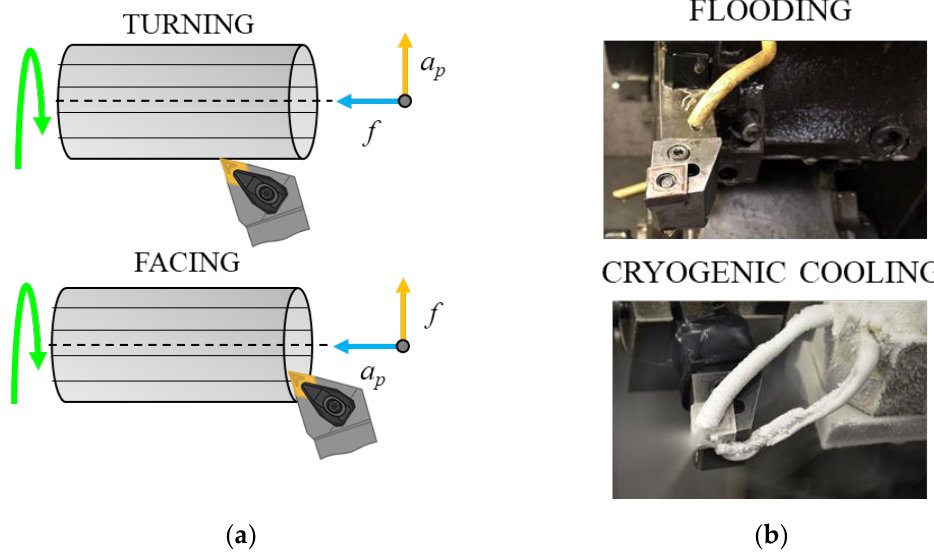
Figure 1. Scheme of the cylindrical turning and facing operations: ( a ) flooding and cryogenic cooling experimental setup ( b ).